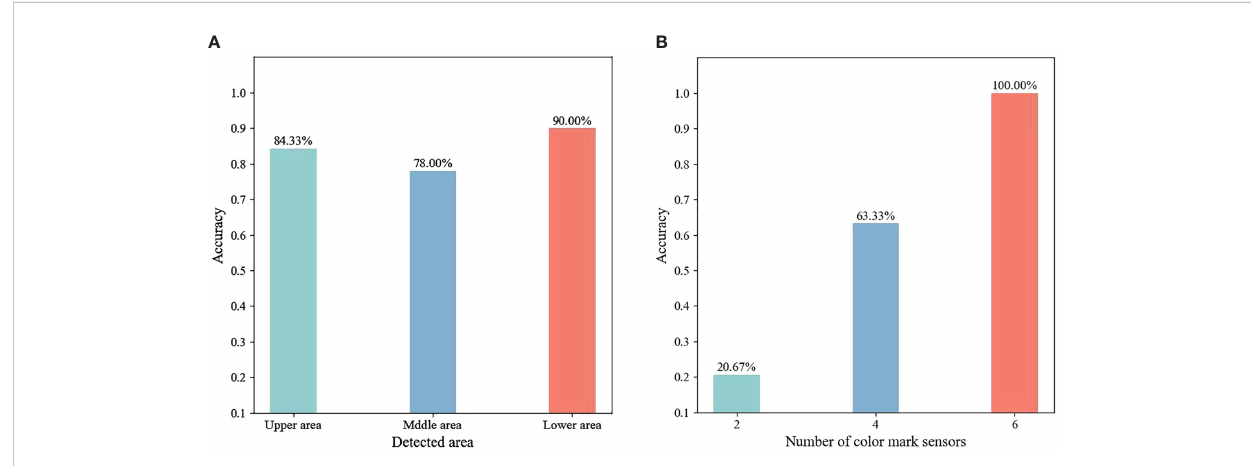
FIGURE 7 (A) Accuracy of detecting different areas, (B) accuracy of different number of sensors being applied.